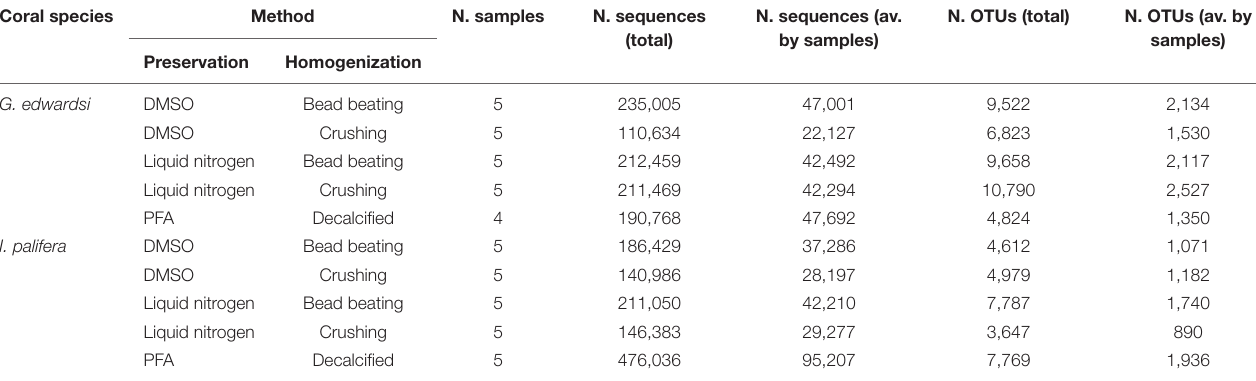
TABLE 1 | Number of sequences and OTUs per treatment. Coral species Method N. samples N. sequences